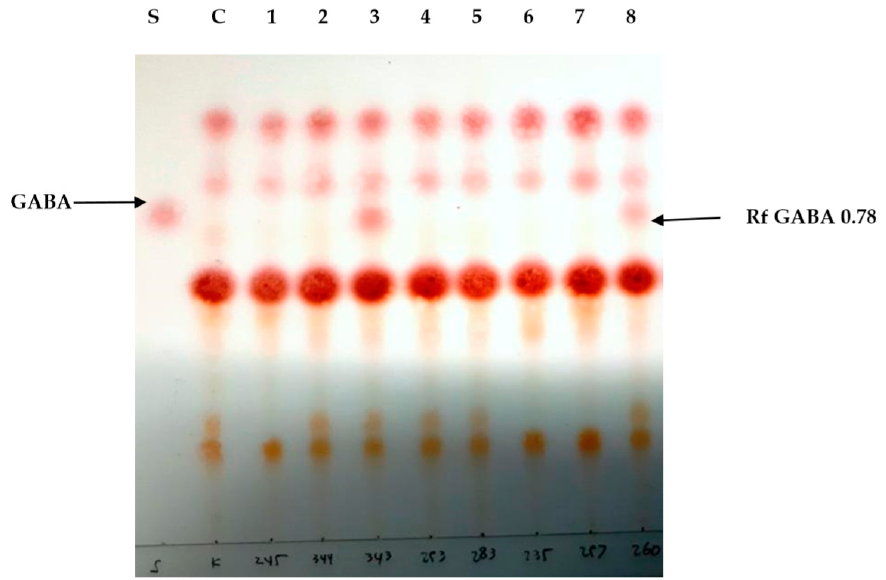
Figure 1. Thin layer chromatography (TLC) screening of GABA–producing LAB. Lane S: GABA standard, Lane C: MRS with 118 mM monosodium glutamate (MSG), Lane 1–8: the strains FNCC 245, FNCC 344, FNCC 343, FNCC 253, FNCC 283, FNCC 235, FNCC 257, and FNCC 260, respectively. All strains were cultivated in MRS broth supplemented with 118 mM MSG and incubated at 37 ◦ C for 48